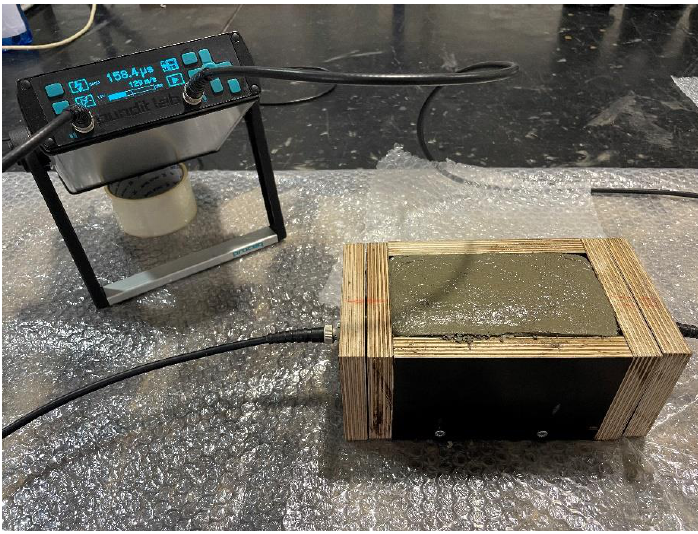
Figure 5. Measurement by the ultrasonic pulse method.